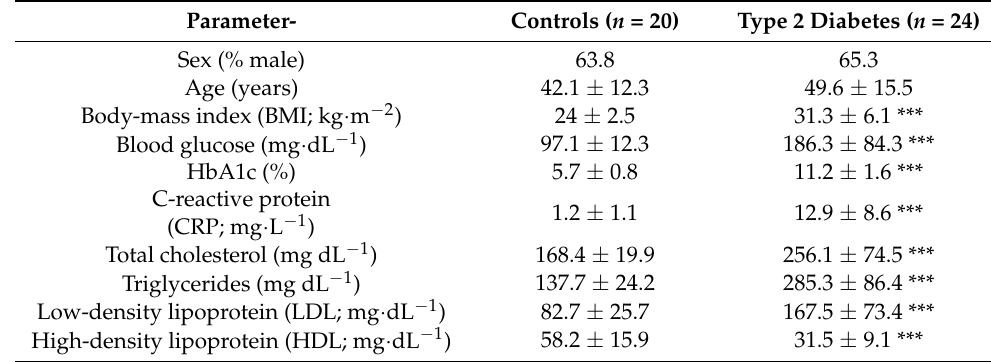
Table 4. Mean baseline characteristics of control and diabetic patient cohorts. All parameters were determined prior to collection. Data are mean ± SD; *** p < 0.001, vs. controls. All other characteristics were not significant ( p >